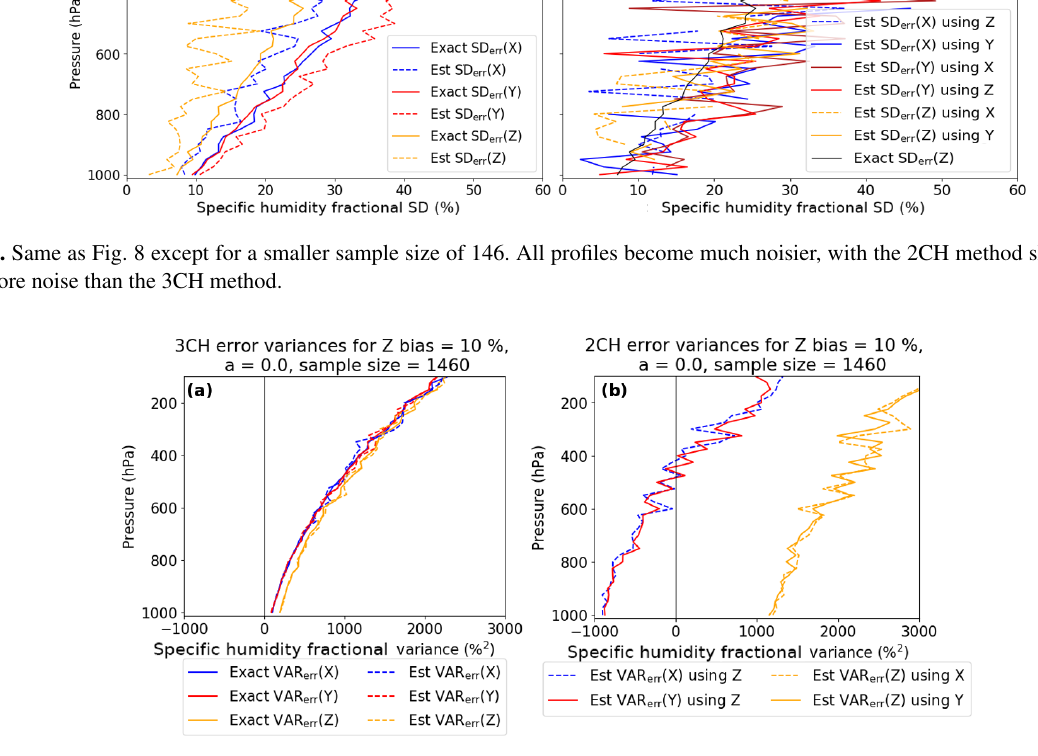
Figure 10. Effect of adding a constant bias of 10% to Z for the 3CH (a) and 2CH (b) methods, for no correlation between X and Z errors (i.e., a = 0). The 3CH method yields reasonable estimates for all variables, while the estimated error variances from the 2CH method are erroneously large for Z (orange) and erroneously low X and Y (blue and